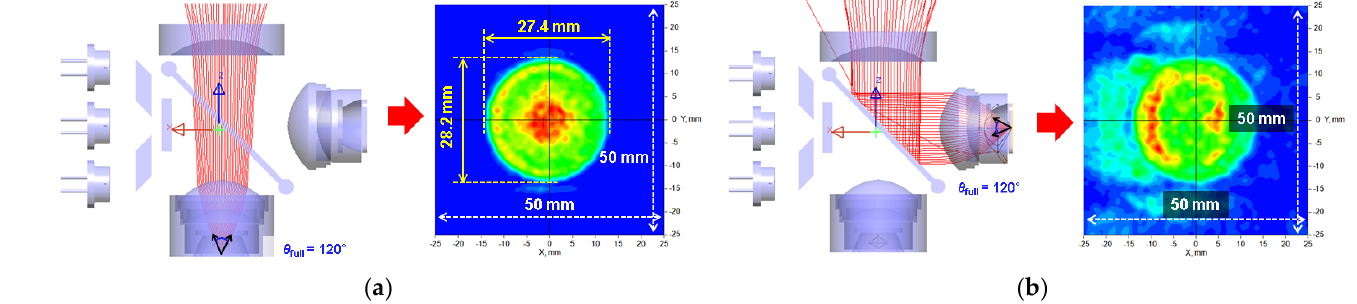
Figure 11. Bidirectional blue laser white light source module with the final designed dichroic filter applied: ( a ) phosphor white light path; ( b ) transmitted blue laser beam path.